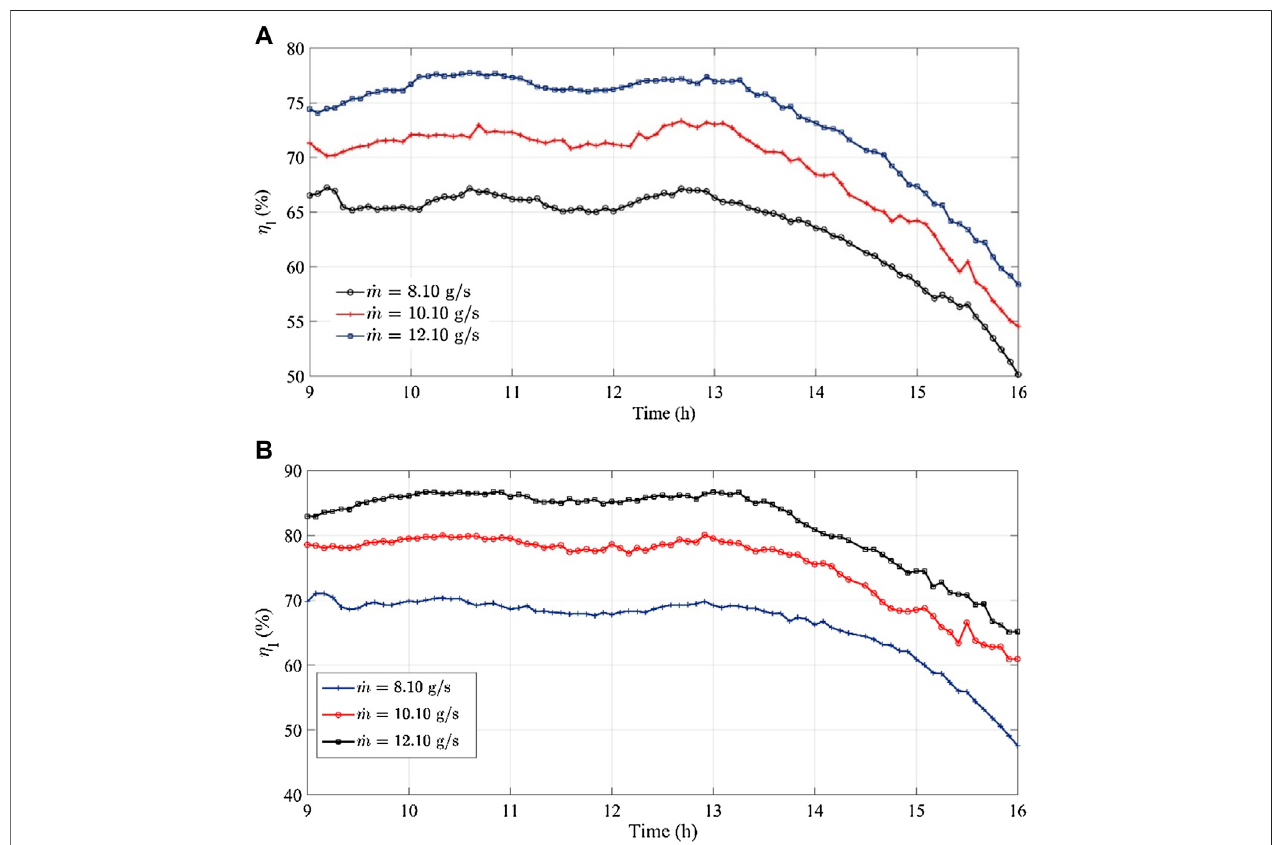
FIGURE 10 | The change in the collector ef fi ciency ( η I ) with time. (A) Flat plate collector; (B) fl at plate collector with fi ns.